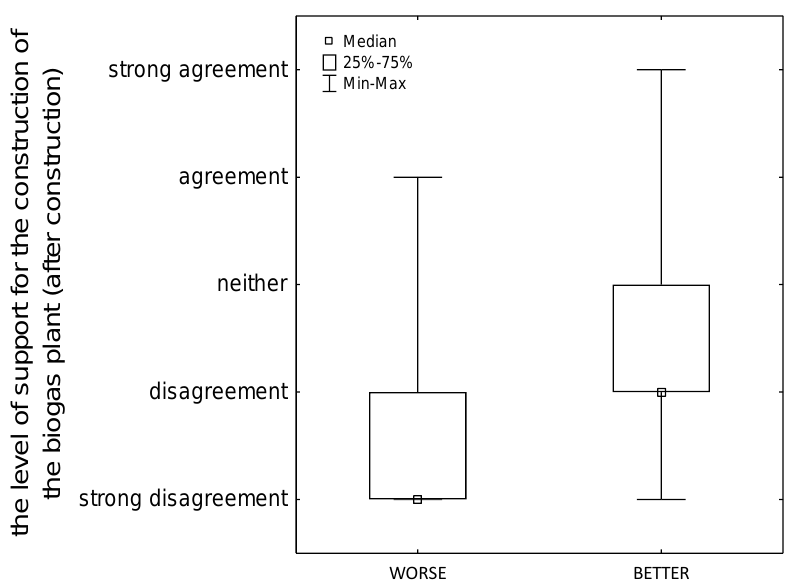
Figure 3. The level of support for the construction of the AD plant in its operational phase.